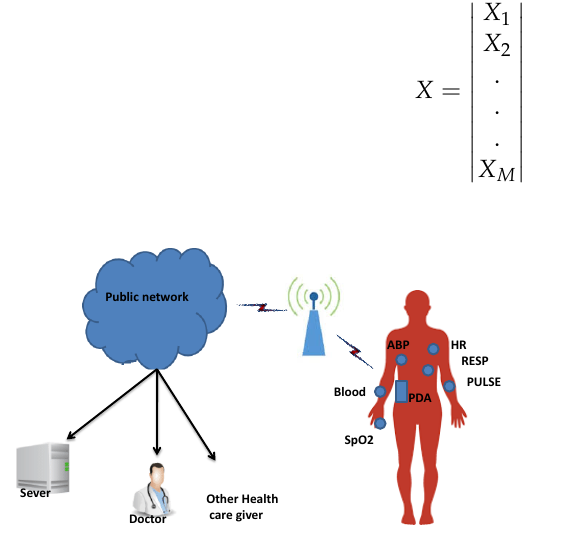
Figure 2. WBAN architecture